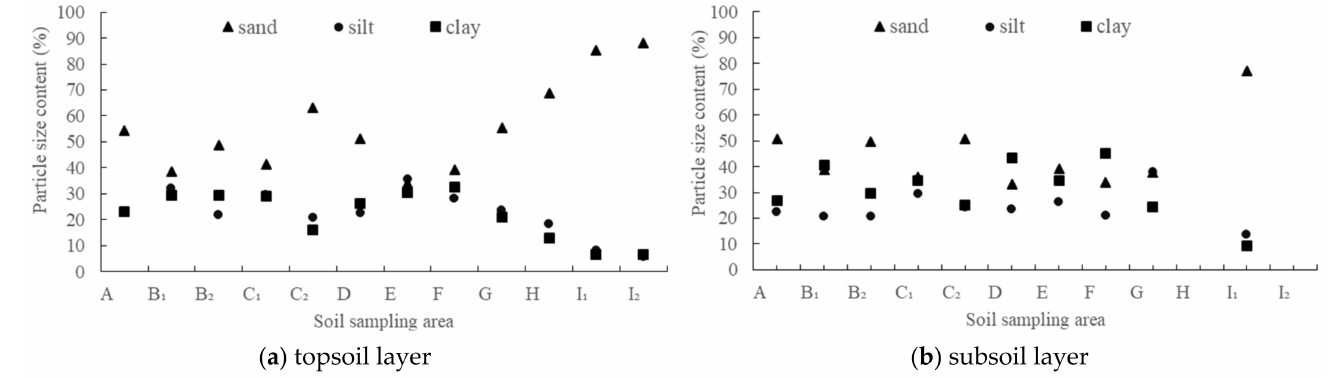
Figure 5. Distribution of soil particle size content at different altitudes.